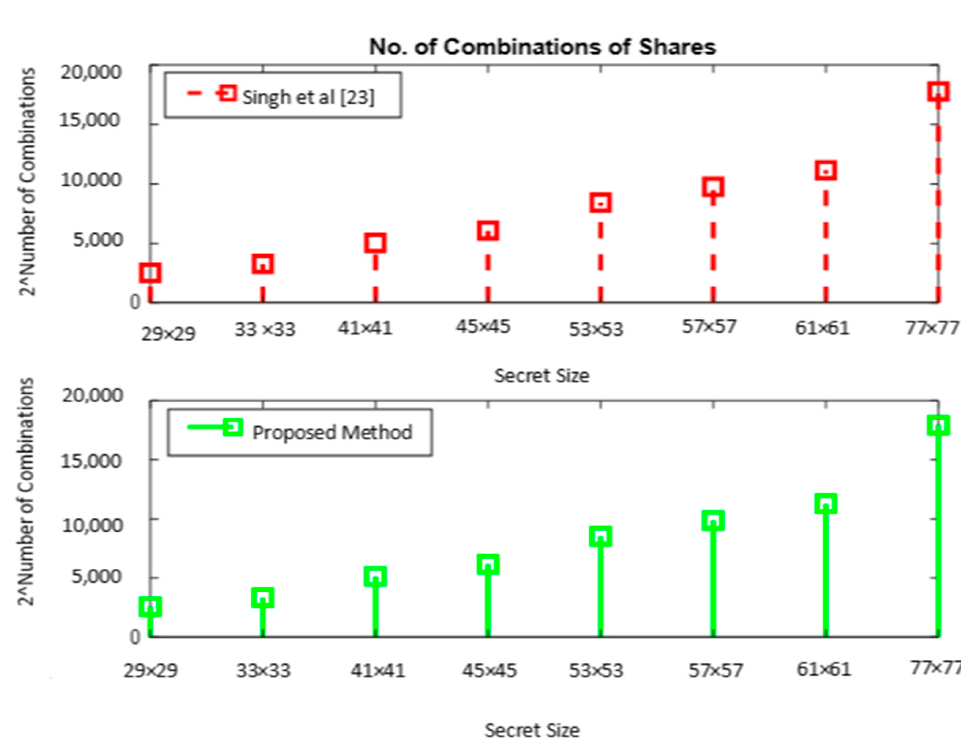
Figure 8. Brute-force attack—number of combinations of shares. Further, the secret image is reconstructed by multiplying S 2 and S 3 first and the resultant with S 1 in the proposed system . As the attacker is unaware of the share labels, all the possible combinations must be tried. For 3 shares, the number of combinations is 2 3 . Two multiplication operations are required between the shares to recover the secret. From the above, the minimum and maximum number of total computations T min and T max can be expressed as in Equations (15) and (16).